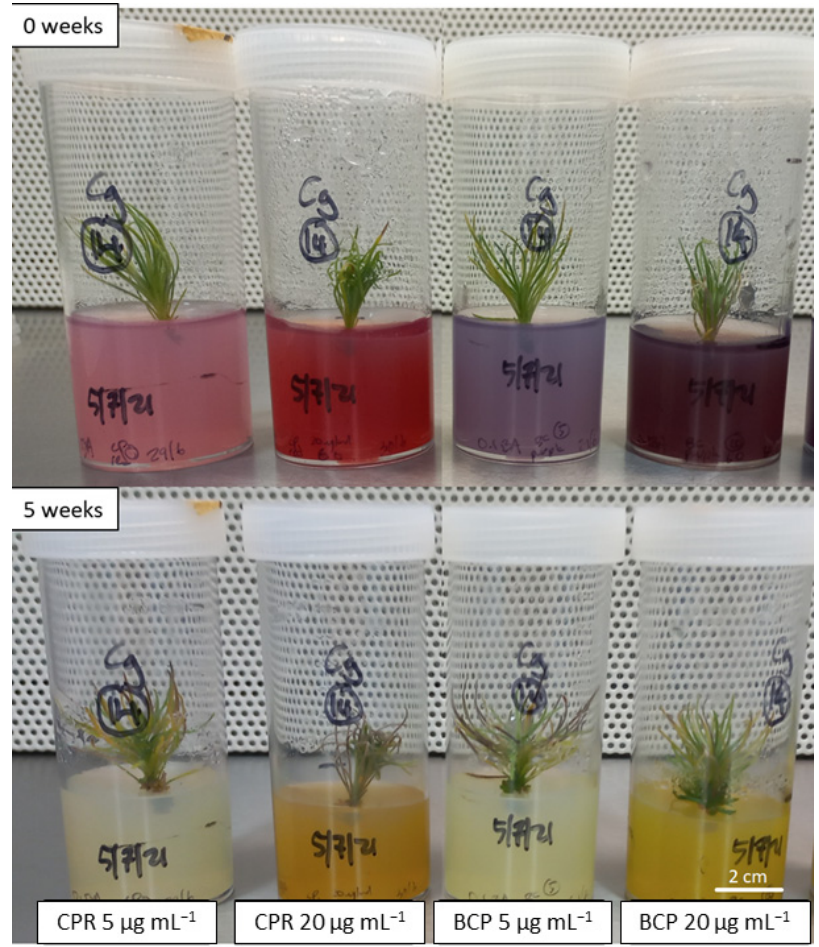
Figure 2. Initial assessment of Conospermum galeatum growing on medium containing chlorophenol red (CPR) and bromocresol purple (BCP) at 5 and 20 µg mL − 1 concentrations for a 5 week period. The initial pH of the medium was approximately 6.0. Colour changes indicate a drop in pH below 5.5 after five weeks, with the colour fading at the 5 µg mL − 1 concentration. A large trial of ten Australian plant species was done to test the combination of bro- mocresol green and bromocresol purple (1:1 and 1:3 ratios) over an eight week period. All species were placed on the same basal medium, starting at approximately pH 5.75. It was observed that the pH dropped by 0.25 pH units after autoclaving (from the pH 6.0 it was set at prior to autoclaving), which is a well-known occurrence where the media pH will change after the autoclaving process [18,19]. Pictures were taken weekly to demonstrate the colour change seen when using the combination pH indicators (Figures 3 and 4). In the 1:3 combination, it was easy to visu- alise colour changes in the first three weeks before the pH of the medium fell towards 5 for many species (Figure 3). By contrast, the 1:1 combination still exhibited a visual colour change when the medium pH was around 5 (Figure 4). While the 1:3 combination was not as sensitive to pH changes occurring in the first two weeks, it was more informative with a few species where acidification of the medium rapidly decreased to pH 5 or lower (i.e., A. viridis , G. scapigera , and P. basistyla ). It was observed that the pH-related colour faded in some of the culture medium towards the end of the eight week period, perhaps as a consequence of possible inactivation or interference with the indicators by secondary